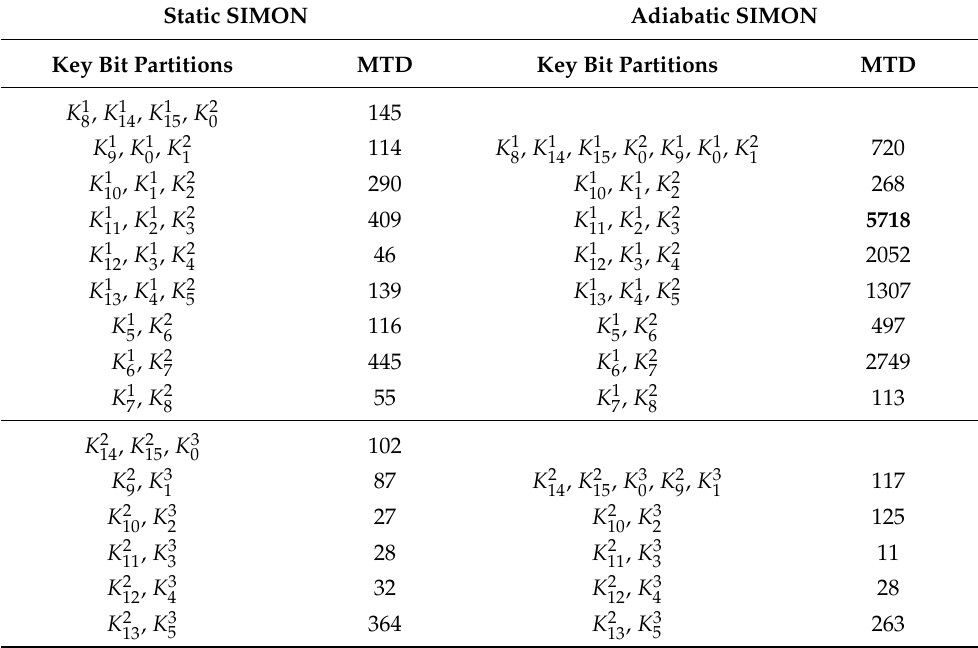
Table 3. MTD for each key-bit partition for static CMOS based SIMON32/64 and adiabatic